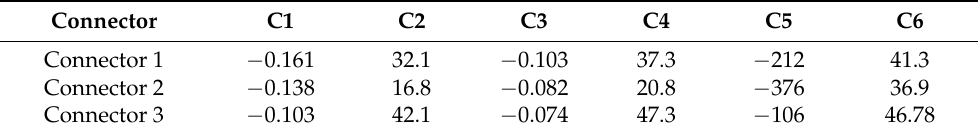
Table 2. Constant values of Equations (1) to (3) for each connector.